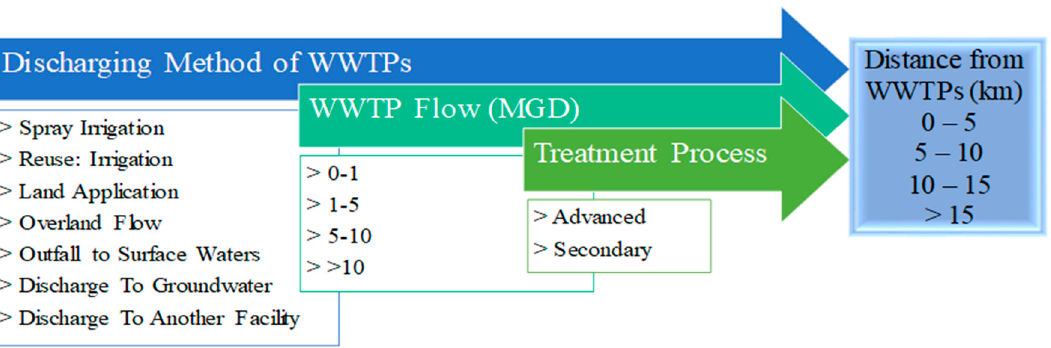
Figure 2. Three-stage classification process for wastewater treatment plants adapted from Paul et al. [19].